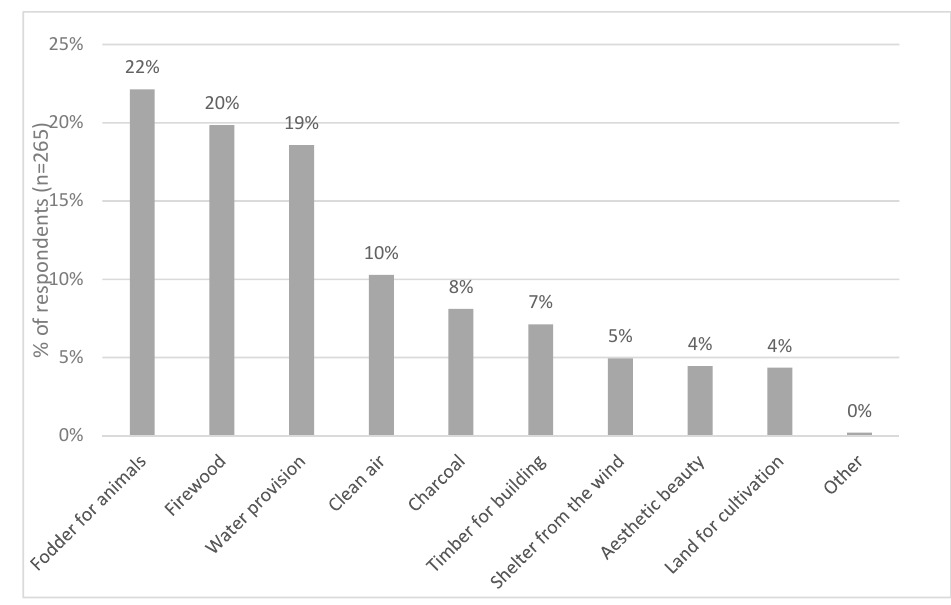
Figure 2 . Perception of the most important ecosystem services (ES) provided by Mt. Marsabit forest (several responses possible).